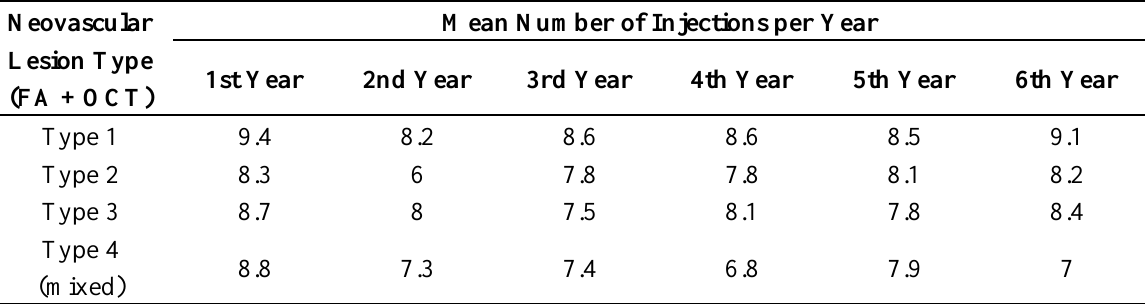
Table 2. Mean number of injections broken down yearly according to neovascular lesion